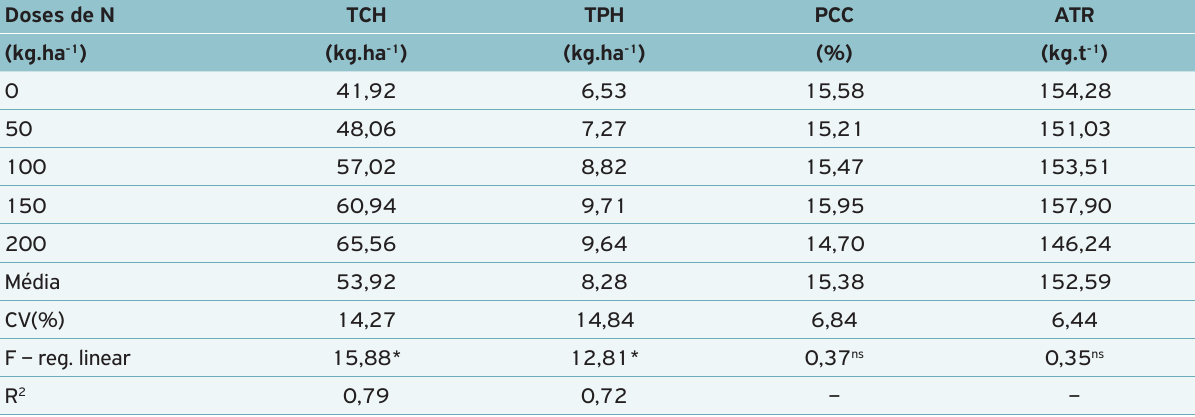
N: nitrogênio; TCH: produtividade de colmos; TPH: produtividade de açúcar; PPC: pol de cana corrigido; ATR: açúcar total recuperável; CV: coeficiente de variação; F–reg. linear: valor de F - regressão linear. *significativo pelo teste F (p < 0,05); ns: não significativo; R 2 :